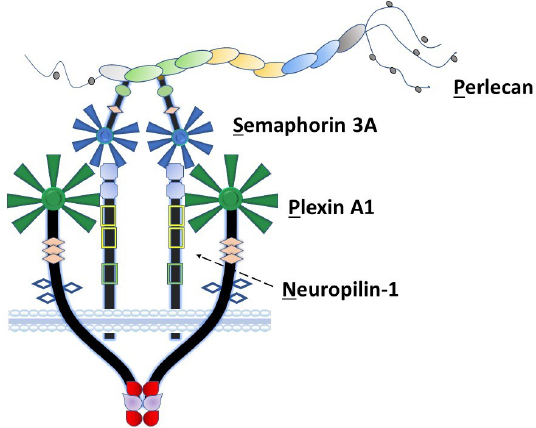
Figure 1. The PSPN Complex forms as a dimer of heterotrimers stabilized by extracellular perlecan. Perlecan/HSPG2 interacts with secreted Sema3A to bind NRP1 (dotted arrow) and plexin A1 to stabilize the PSPN Complex and prevent PCa dyscohesion. Dm IV-3 of perlecan (light green oval) interacts with the Ig module (light green) in the Sema3A dimer. Subsequently, this stabilized dimer interacts with the a1 domain of NRP1 (light blue square), which acts as a bridge between Sema3A and plexin A1. The sema domains of both Sema3A (blue) and plexin A1 (dark green) interact at this a1 NRP1 domain as a dimer of heterotrimers.